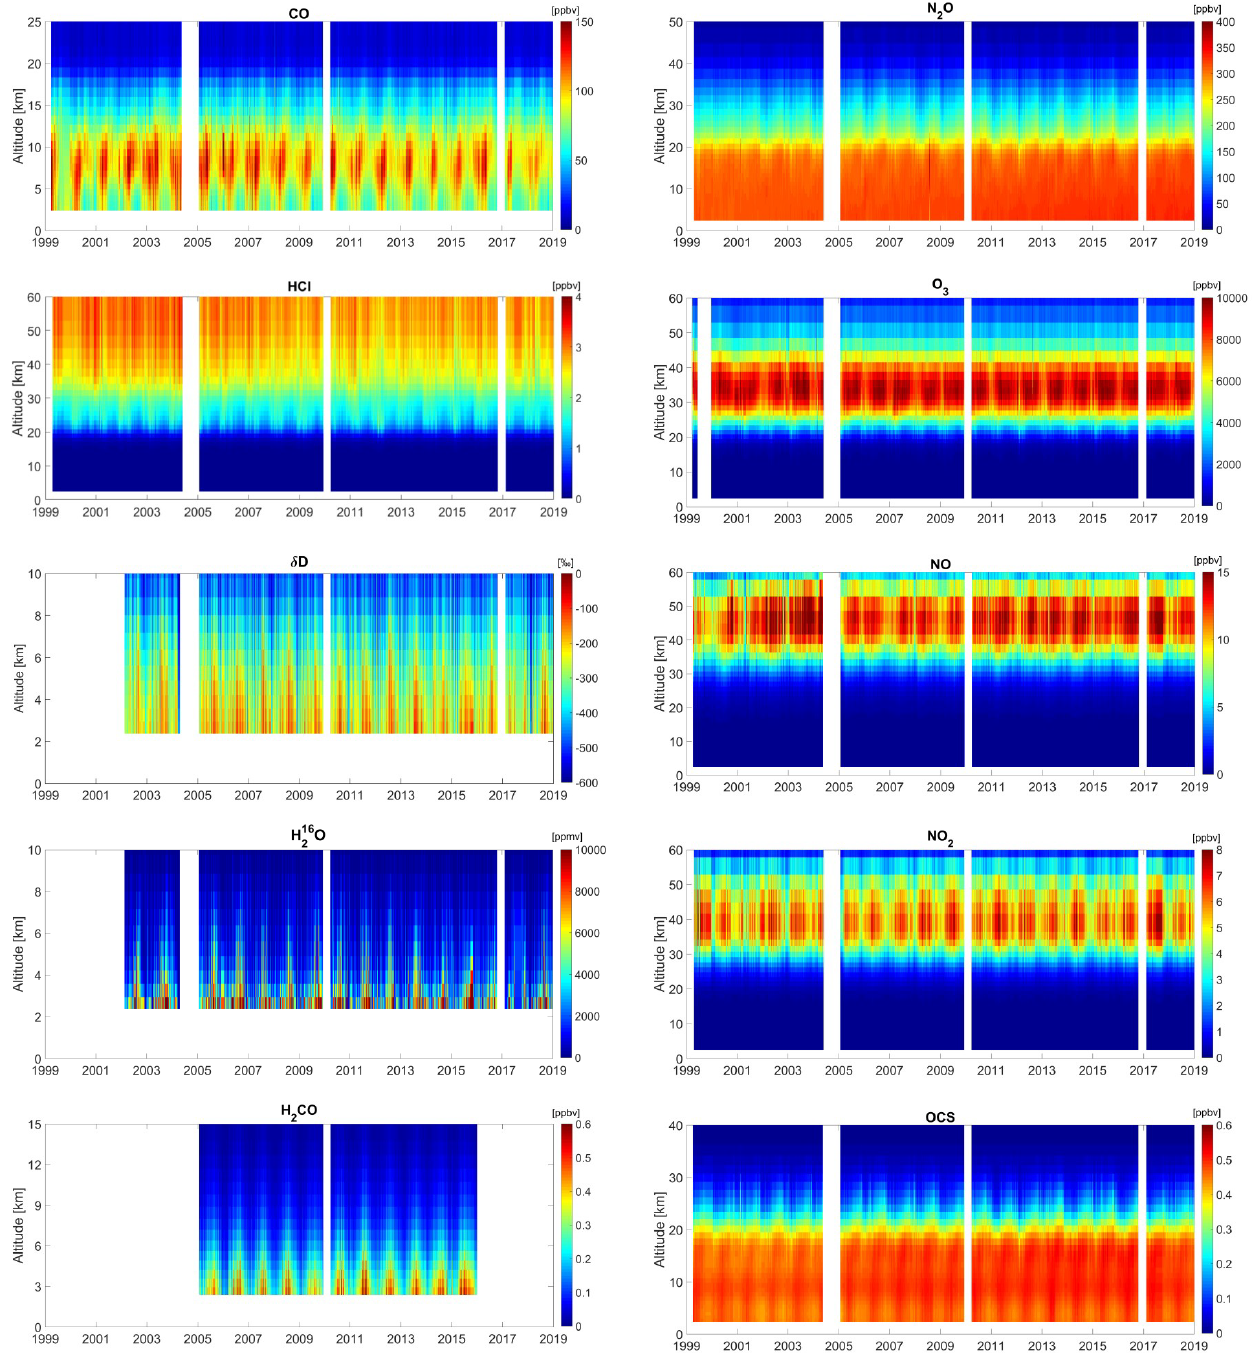
Figure 10. As for Fig. 9, but for CO, HCl, δ D, H 16